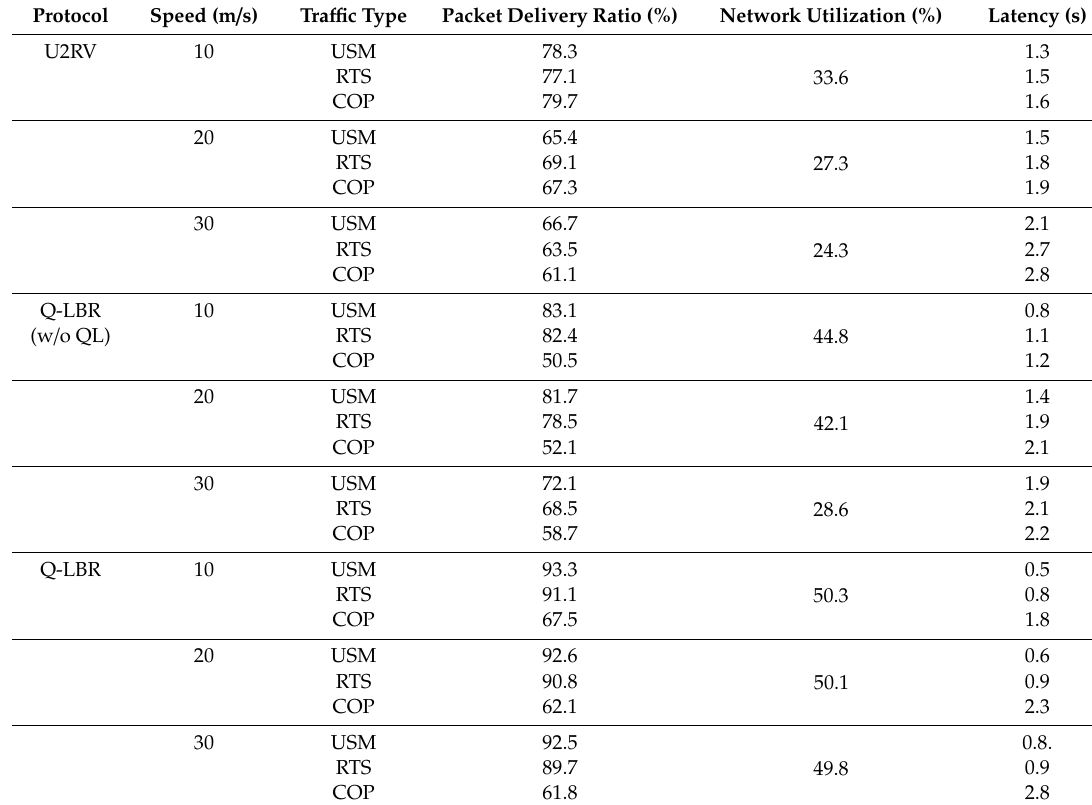
Table 3. Simulation results for varying the speed of the nodes (all tra ffi c = 10 r / s).